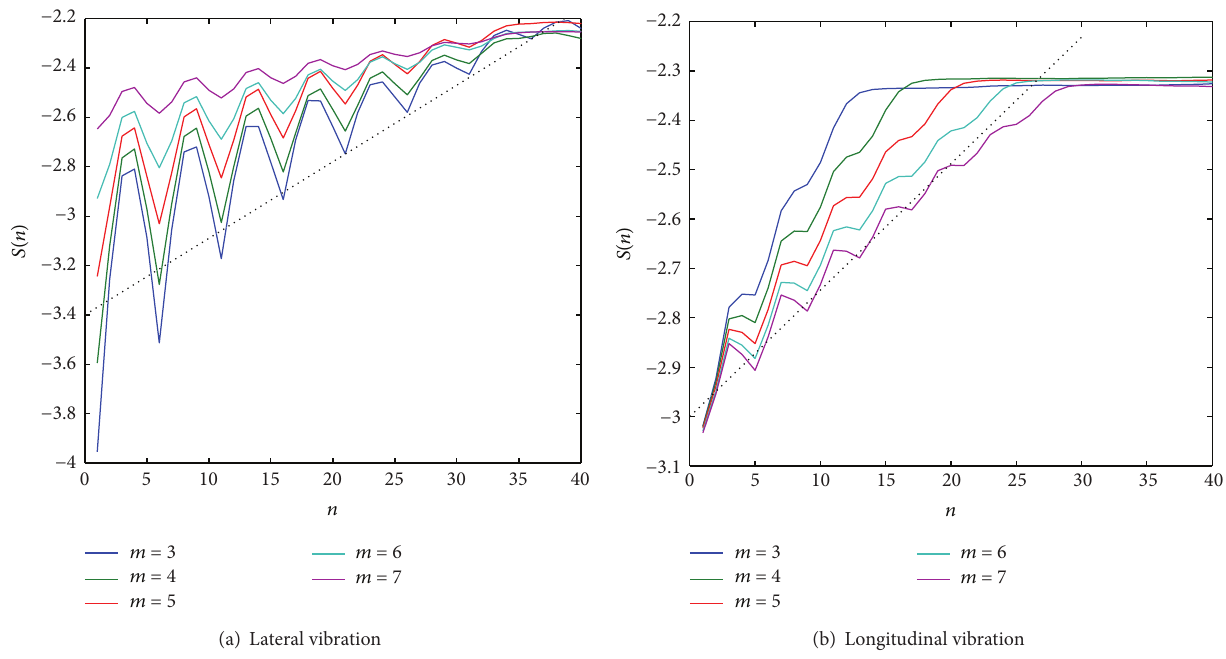
Figure 7: Calculation of the largest Lyapunov exponent of the lateral vibration and longitudinal vibration and the effective expansion rate 𝑆(𝑛) , of which the linear slope in dependence on 𝑛 is a robust estimate for the Largest Lyapunov exponent (using Tisean package [1], version